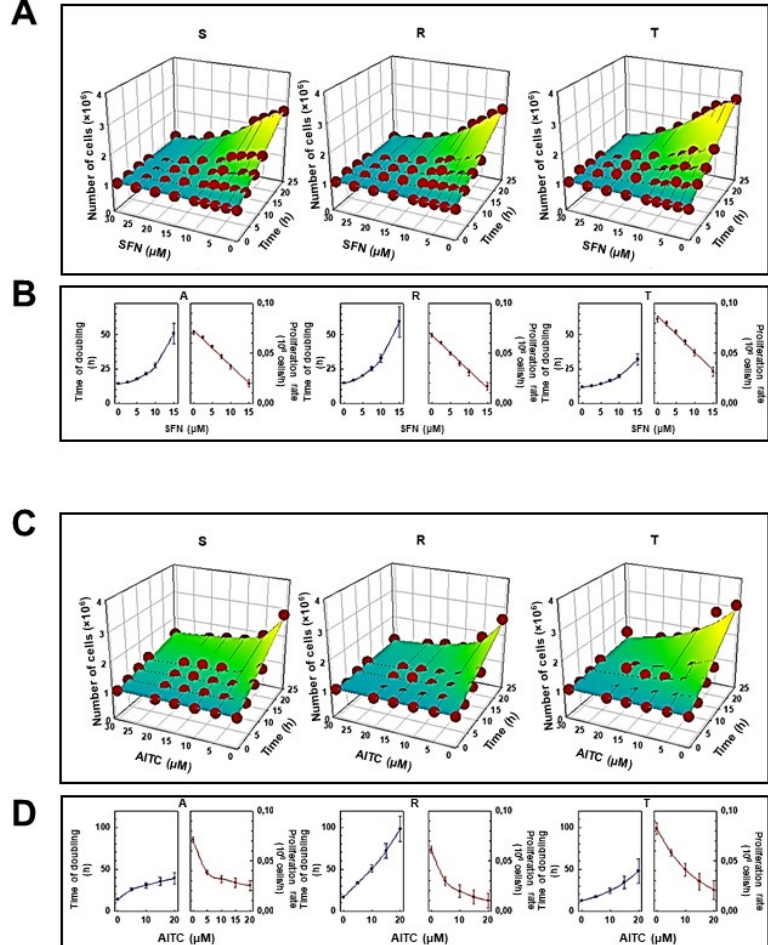
Figure 2. Effect of SFN (panel A , B ) and AITC (panel C , D ) on the proliferation of S, R and T cells. Experimental data (Numbers of viable cells from three independent experiments, S.E.M. values never exceed 10%) were fitted according to Equation by nonlinear regression and were plotted as a function of culturing time period (0–24 h) and concentration of either SFN (panel A ) or AITC (panel C ) in three-dimensional mesh plots. Values of doubling times and proliferation rate together with the corresponding standard errors were computed from Equation and are plotted as a function of either SFN (Panel B ) or AITC (Panel D ) concentration. Table 1. Values of IC 50 for SFN or AITC obtained by nonlinear regression of data for S, R and T cell proliferation according to Equation.